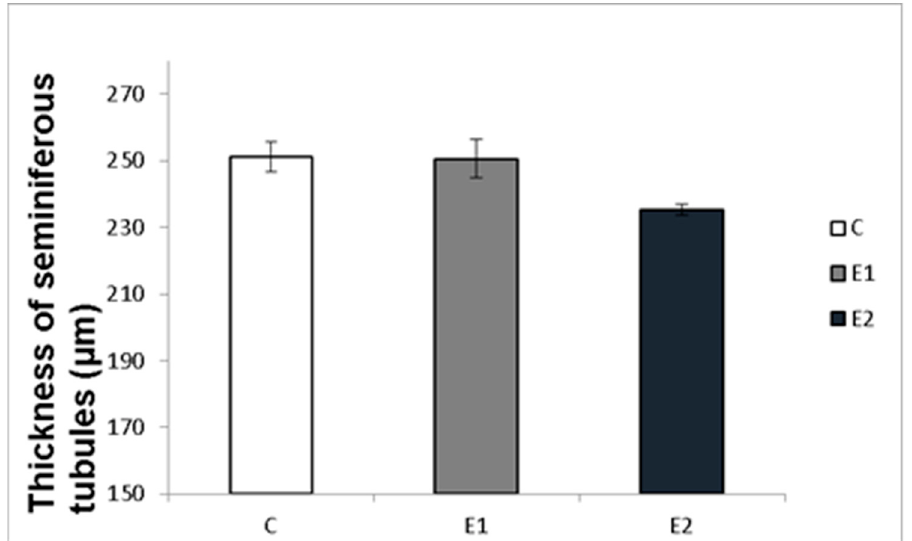
Figure 7. Effect of green tea on testicular seminiferous tubules. C (without dietary green tea). E1–5 g green tea/100 kg normal food. E2–20 g green tea/100 kg normal food. Values and error bars express means ± SEM.